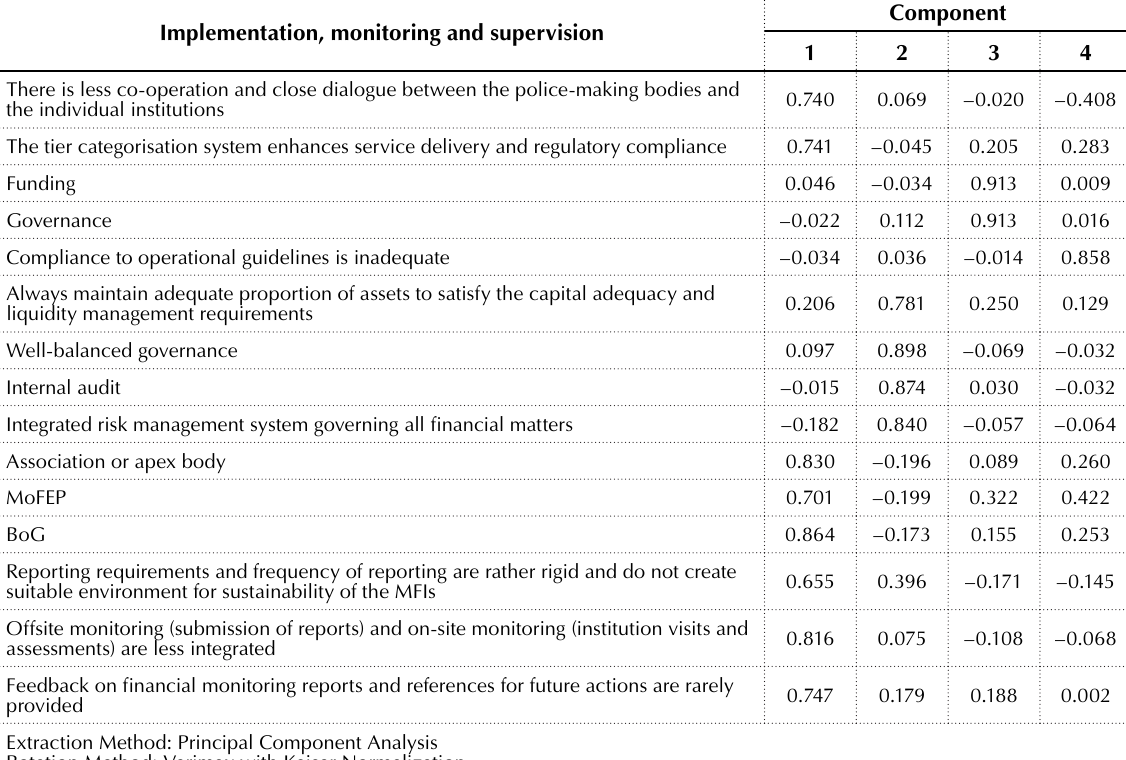
Table 2. Rotated Component